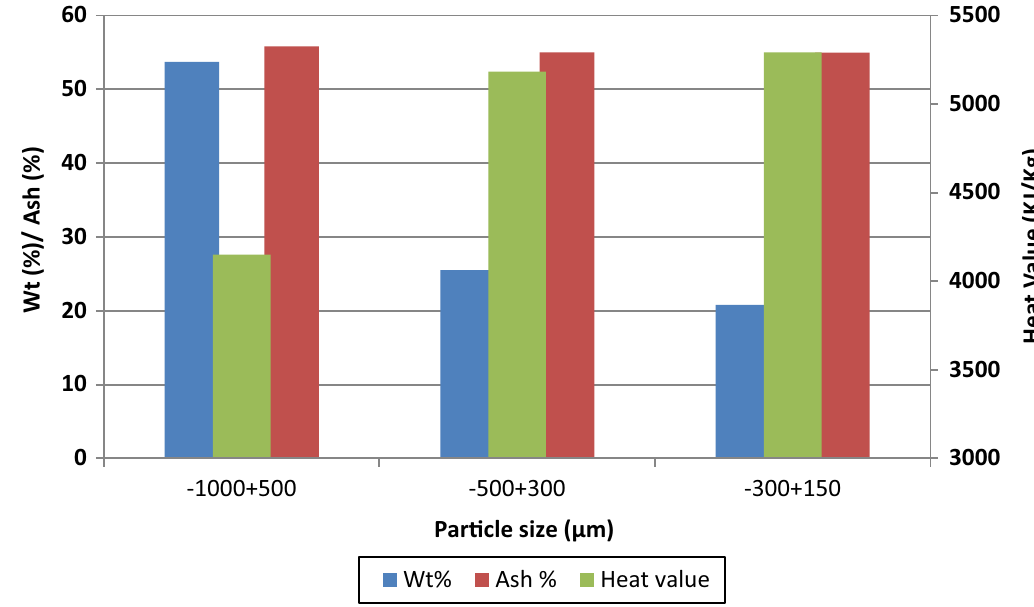
Fig. 2 Characterization of feed sample in terms of particle size distribution and heat